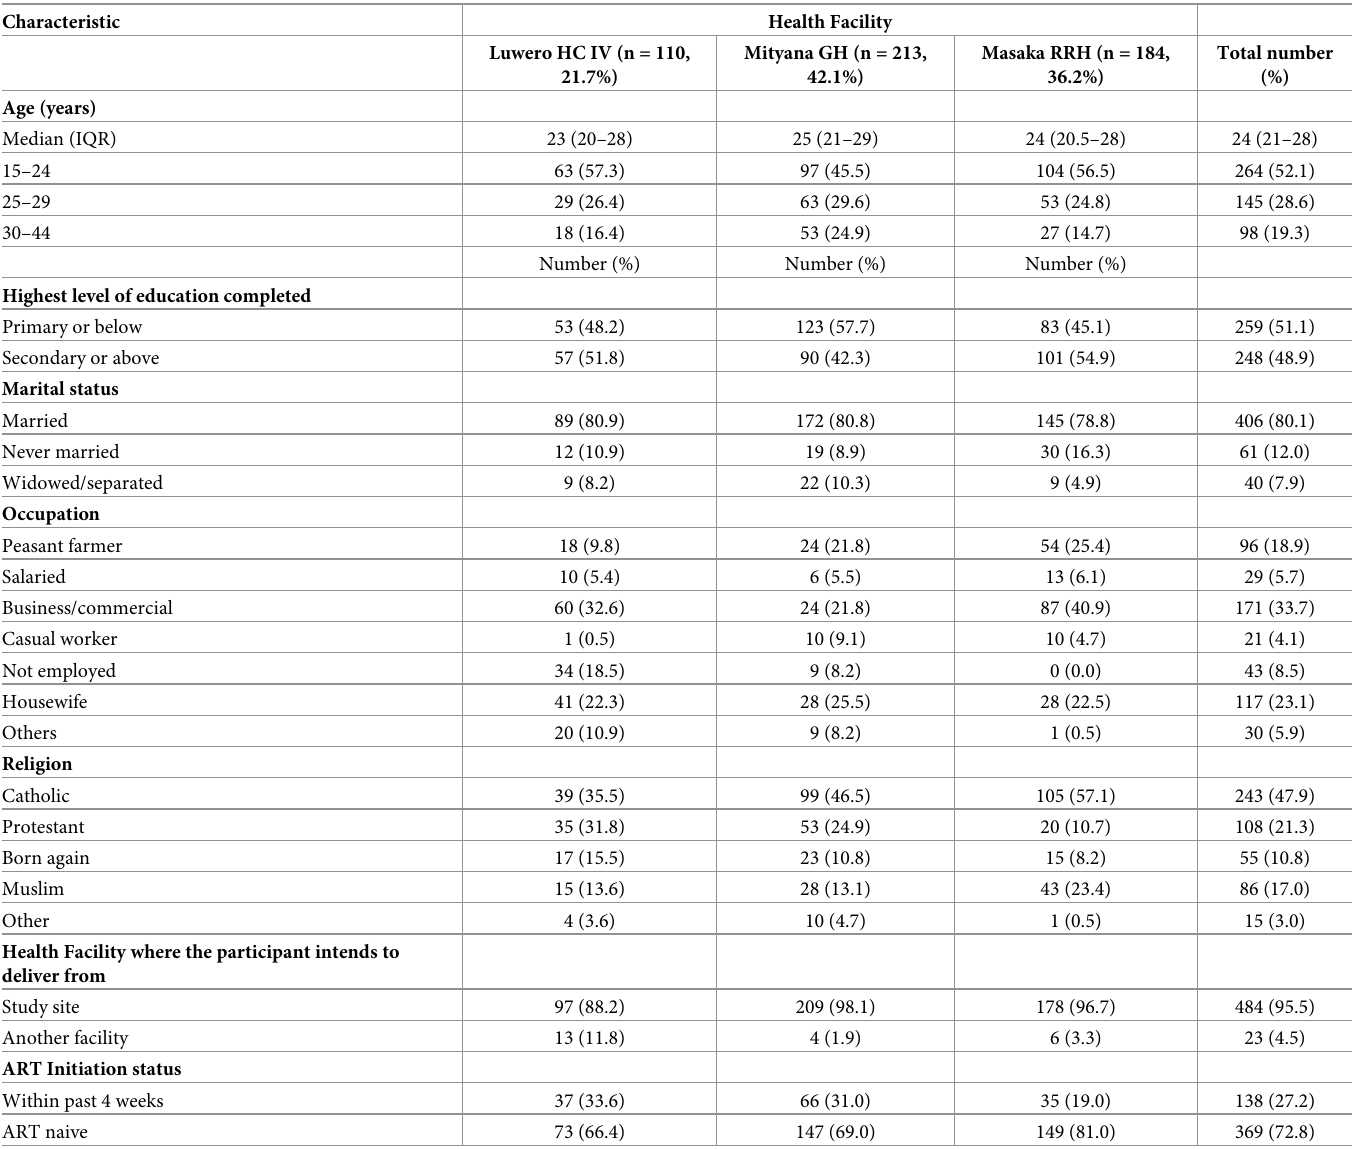
Table 1. Baseline characteristics of HIV positive pregnant women recruited into the study (N =